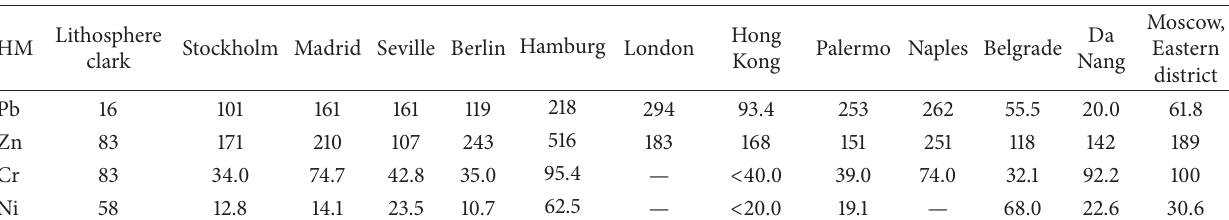
Figure 5: Location of areas of actual, permanent, and relict pollution in the Eastern district of Moscow according to anomalies in soils and snow cover. Table 5: Clarks in the lithosphere [15] and the average contents of Pb, Zn, Cr, and Ni in soils (mg/kg) of the various cities of the world (compiled by the authors according to [16–24] and to own data for the Eastern district of Moscow,